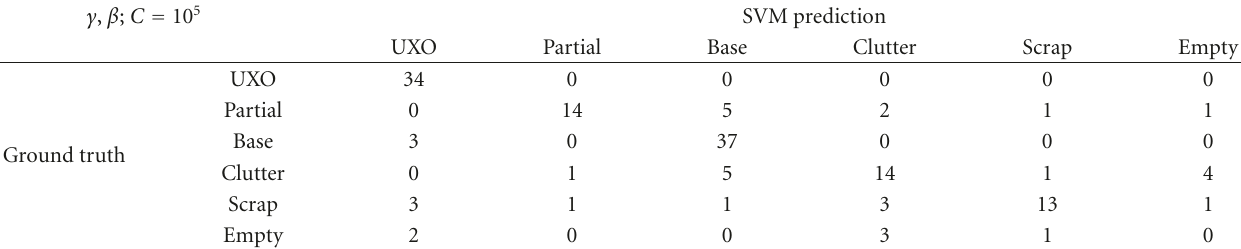
Table 3: SVM classification of Camp Sibert anomalies using γ and β with C = 10 5 . γ , β ; C = 10 5